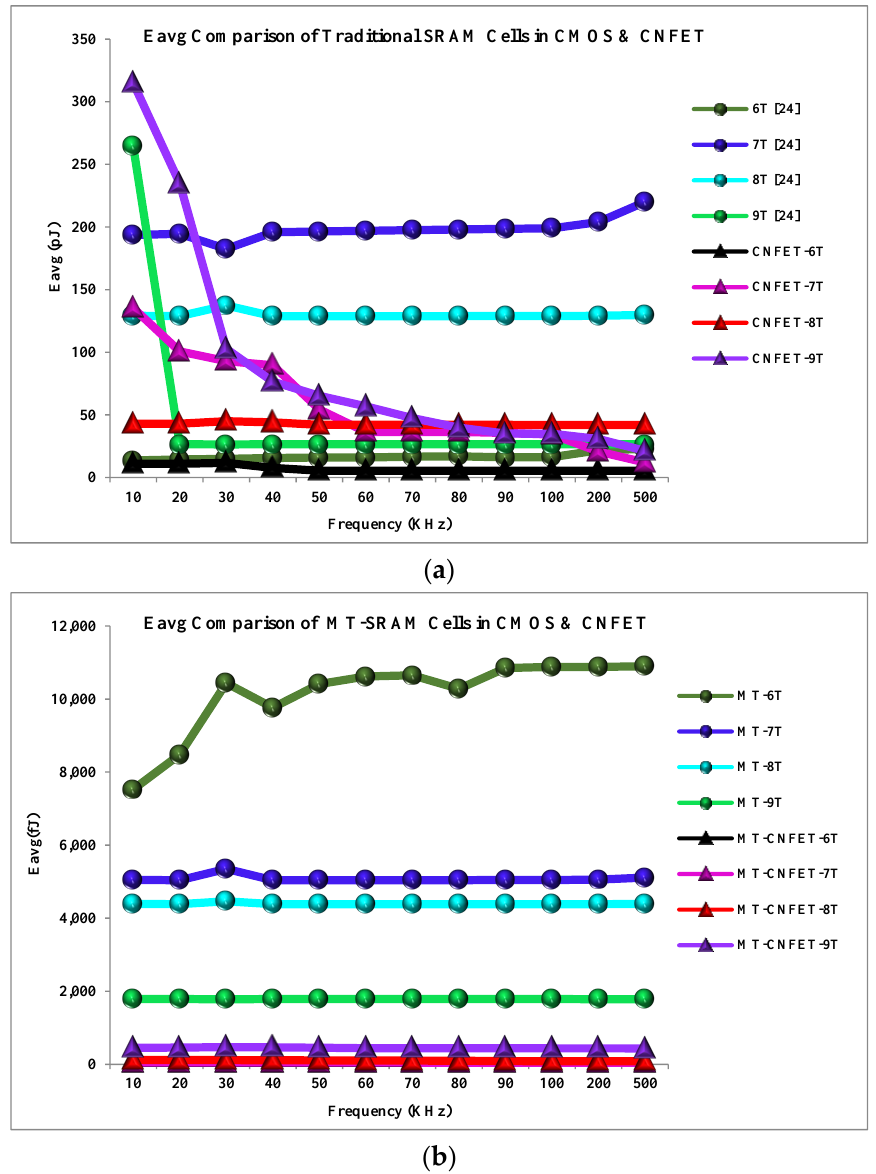
Figure 14. ( a ) Eavg Comparison of Traditional SRAM Cells in CMOS and CNFET. ( b ) Eavg Comparison of Proposed MT - SRAM Cells in CMOS and CNFET.